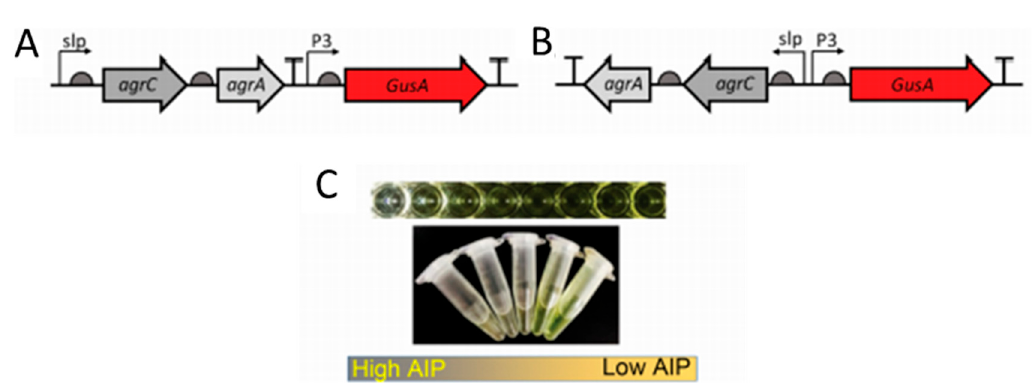
Figure 3. Probiotic biosensor schematic. ( A ) Sensor 1 with pSIP409 plasmid. ( B ) Sensor 2 with pSIP409 plasmid and a flipped slp - agrC fusion. ( C ) GusA reduction in the presence of high autoinducing peptides (AIPs). Reprinted with permission from [73]. Copyright 2018 American Chemical Society.